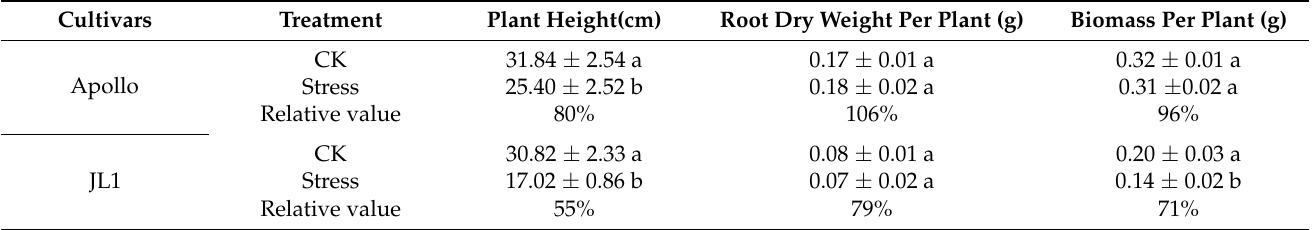
Table 2. Effects of NaCl stress on plant height and biomass of two asparagus